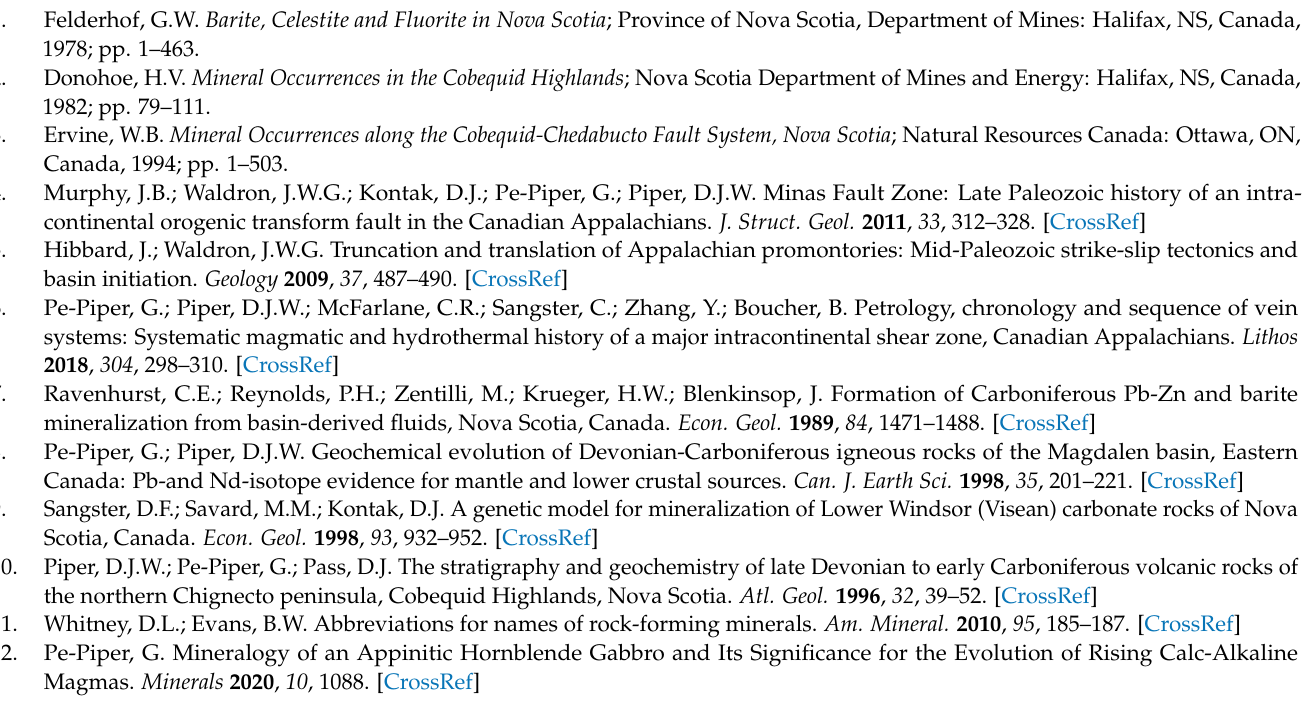
Table S1: Barite mode of occurrence, Table S2: Country rock XRF geochemistry, Table S3: